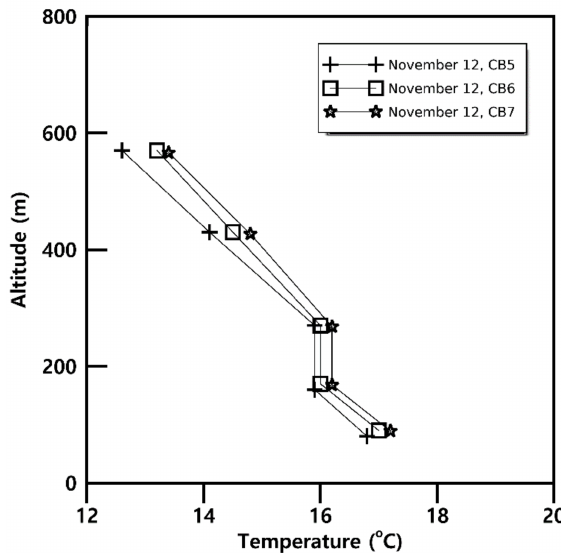
Figure 5. Temperatures measured by Merlin IV (three higher levels) and ARAT (two lower levels). Six segments were divided from point B to point A via point C along the long flight